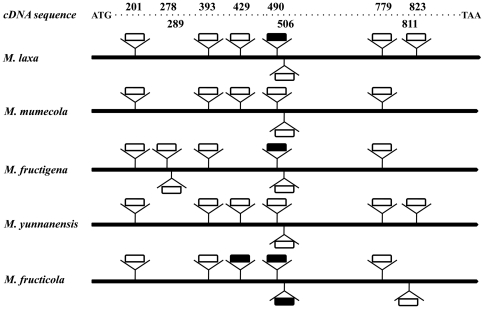
Exon/intron organization of the Cyt b gene from five Monilinia species.Schematic of Cyt b gene exon and intron organizations from Monilinia species showing intron positions and intron sequence similarities. Identical intron symbols at the same nucleotide position indicate high sequence similarity. For example, at position 490, M. laxa and M. fructigena had homologous introns, and M. mumecola, M. yunnanensis and M. fructicola had homologous introns but the two groups of introns did not share high sequence similarity.